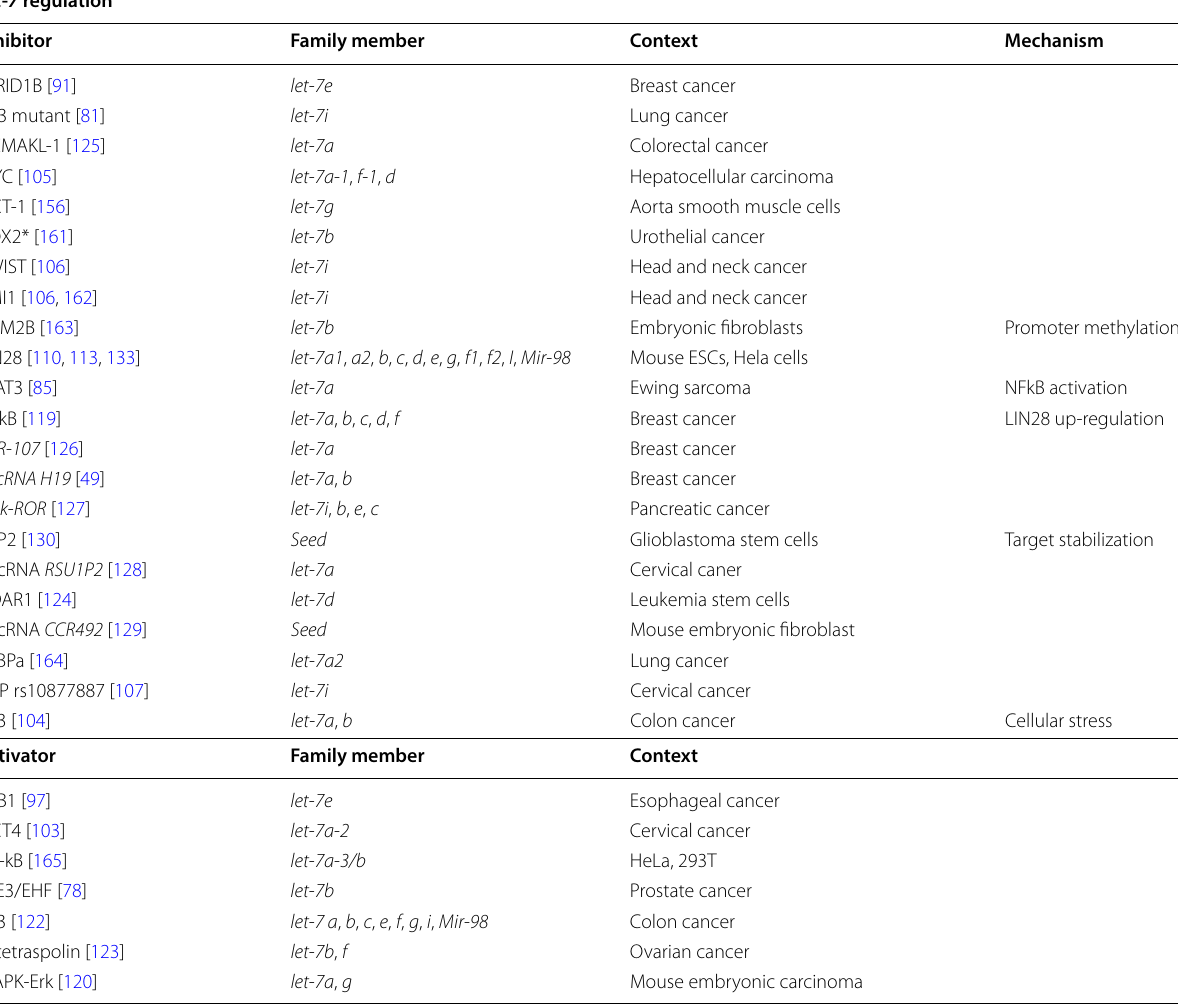
*Indirect by inducing promoter